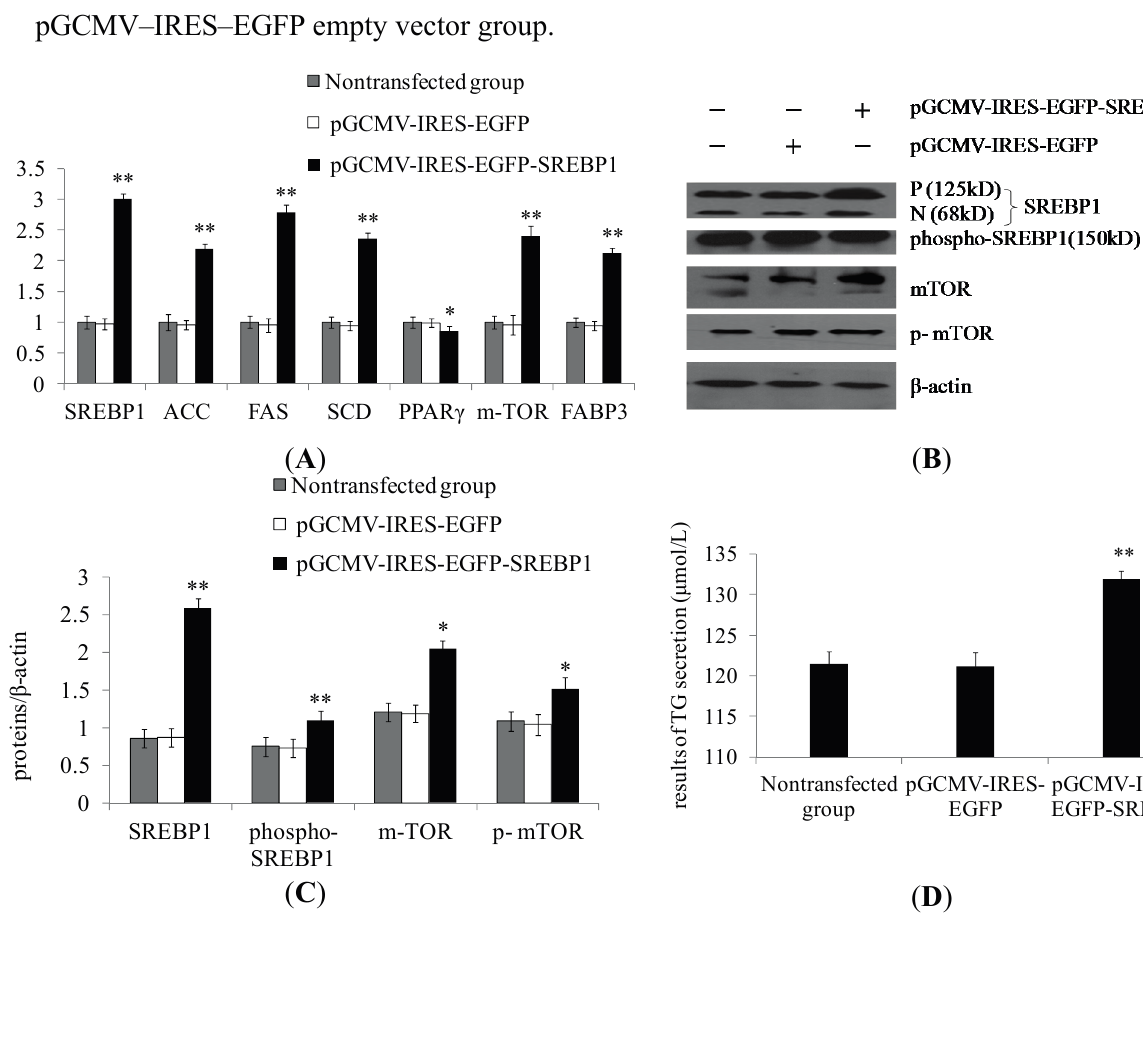
Figure 1. Effect of sterol regulatory element-binding protein 1 (SREBP1)